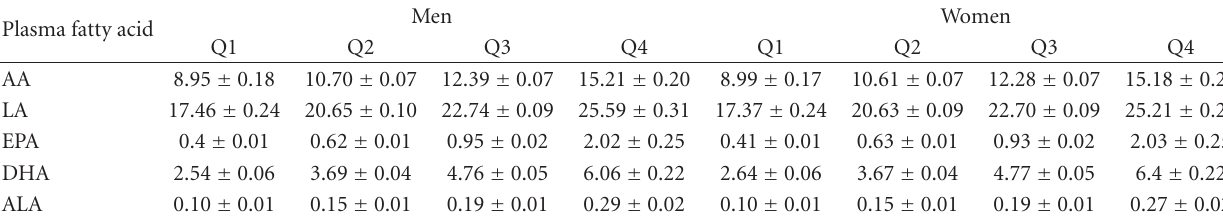
Table 4: Mean plasma phospholipid fatty acid quartile values, by gender. ‡